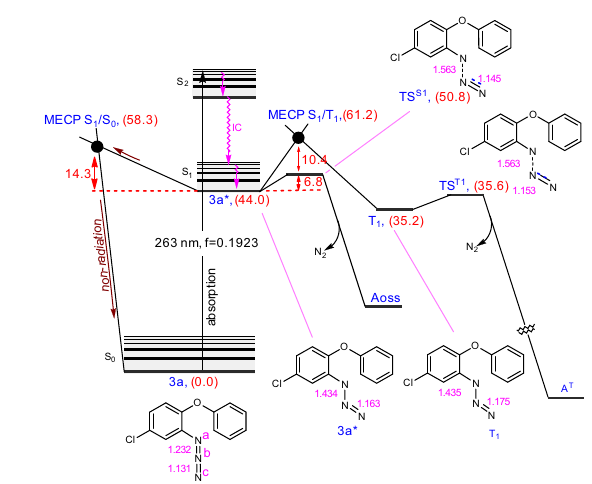
Fig. 6 | Calculated potential energy pro fi le for light-driven decomposition of aryl azide 3a . The relative potential energies are given in